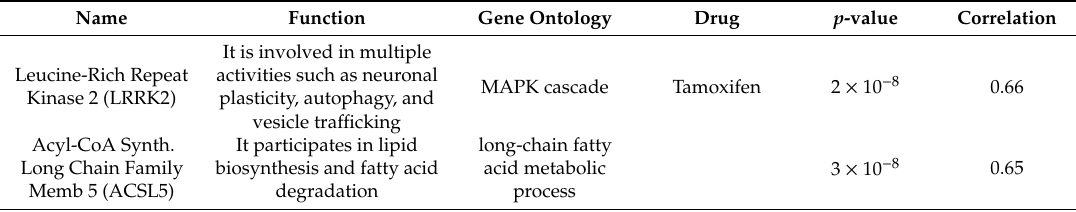
Table 1. Top 10 genes correlated to